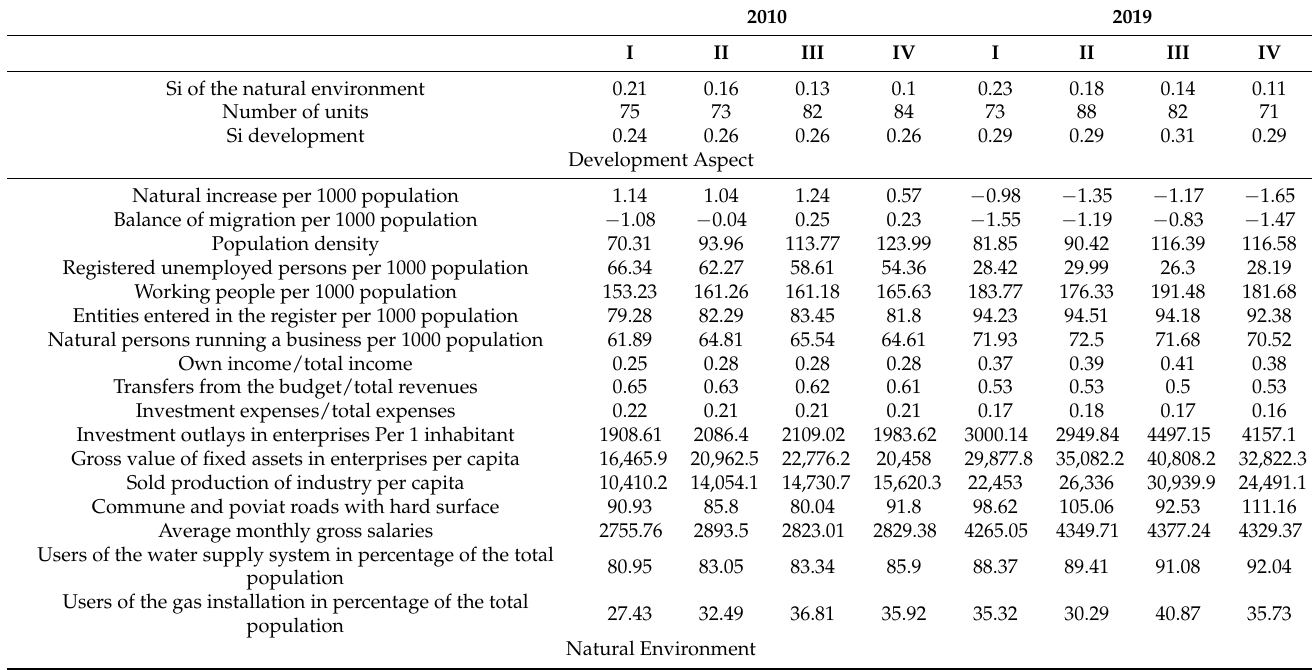
Table 3. Statistical characteristics of diagnostic variables of Polish poviats in 2010 and